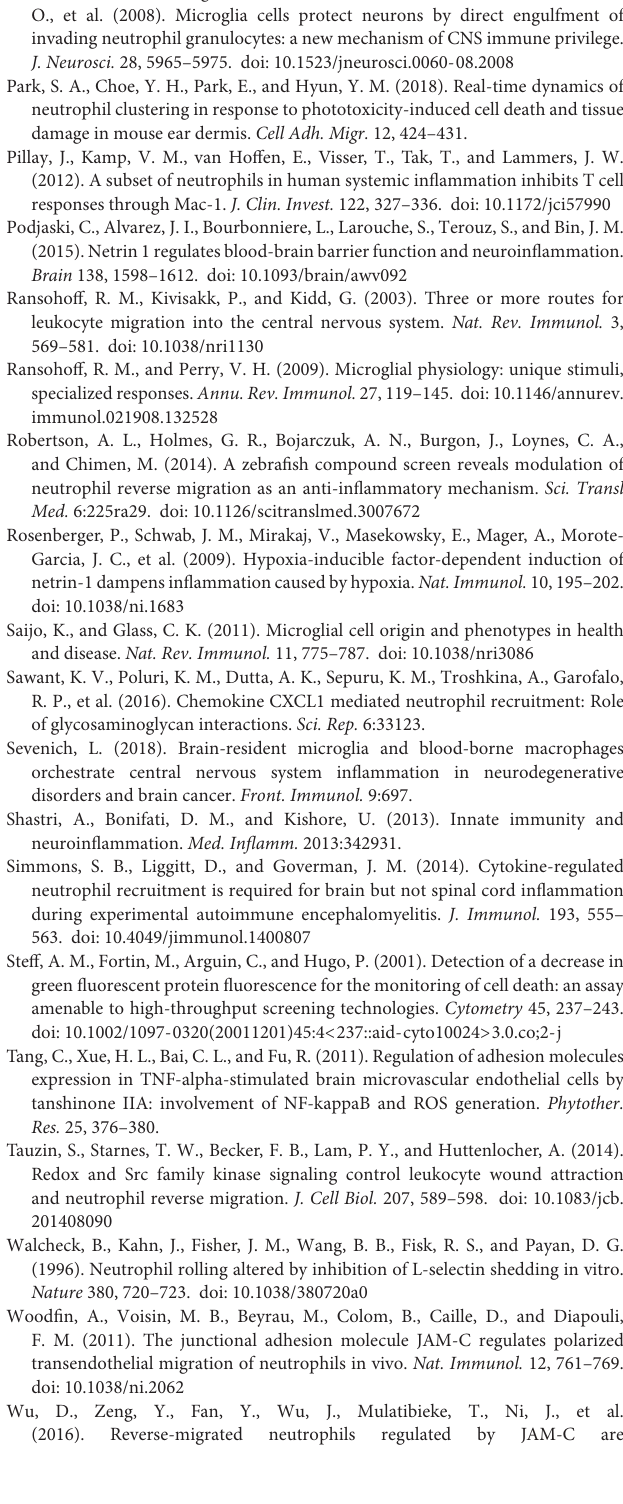
Frontiers in Cell and Developmental Biology |